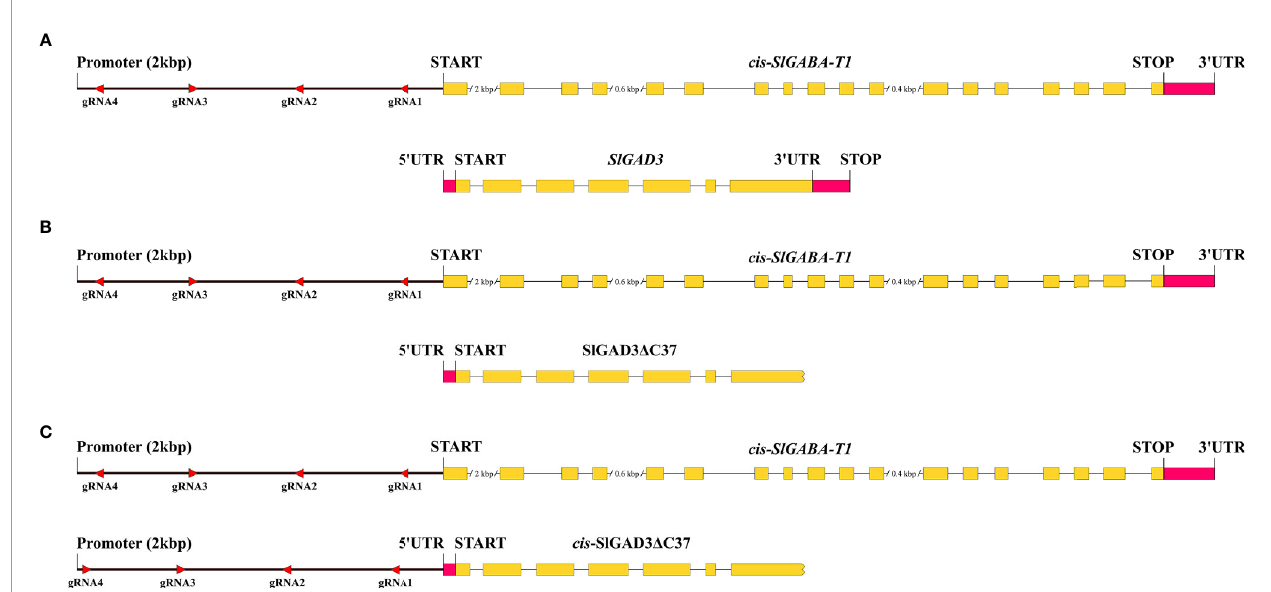
FIGURE 2 | Cis -engineering approaches of SlGABA-T1 and SlGAD3 promoters to enhance the GABA content in tomato. (A) Cis -engineering of the promoter region of SlGABA-T1 while SlGAD3 remained the wild type to observe the effects of SlGABA-T1 CRE editing. (B) Cis -engineering the promoter regions of SlGABA-T1 of the SlGAD3 D C37 GABA improved line to exploit the potential synergistic effects of the cis -engineering and coding sequence targeting approaches. (C) Cis -engineering of the promoter regions of SlGABA-T1 and SlGAD3 D C37 to maximize GABA